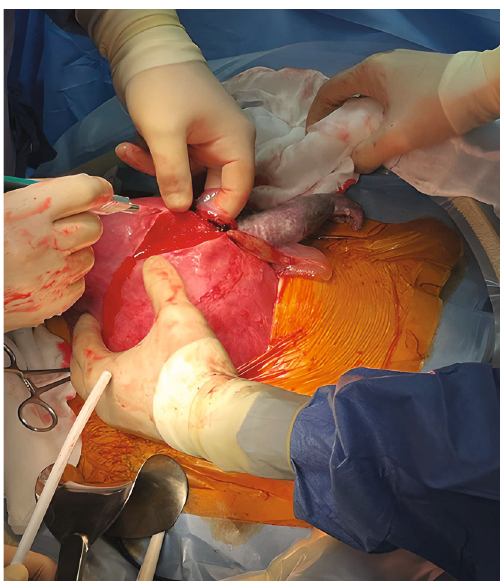
Figure 2: Corporal incision. Right arm of fetus falls out of